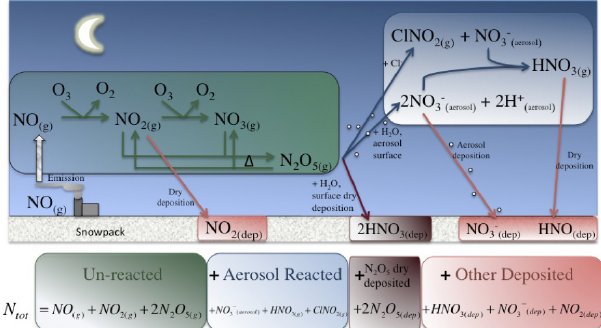
Figure 1. A nocturnal nitrogen schematic with emphasis on N 2 O 5 reactivity. The total nitrogen equation (N tot ) is a sum of the total column-integrated nitrogen from emitted NO x , divided into specia- tion